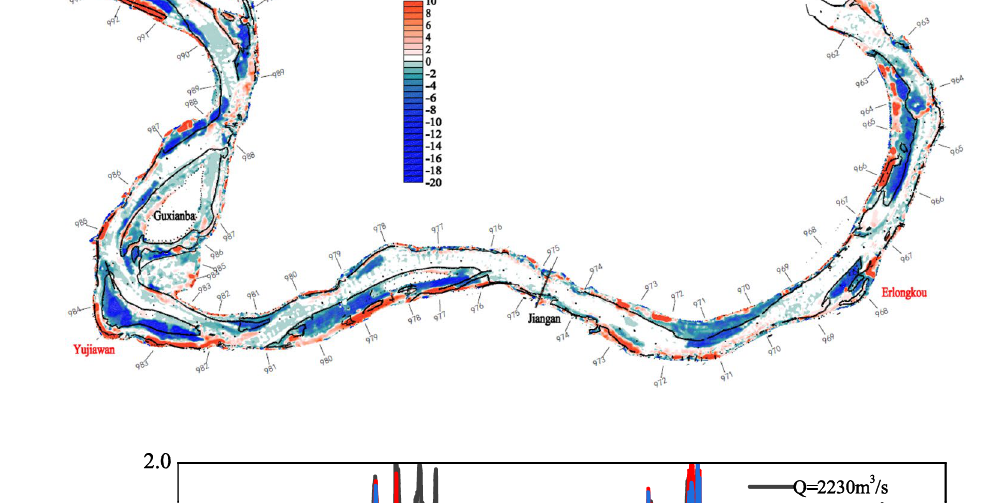
Fig. 21 The water surface line change for the three working